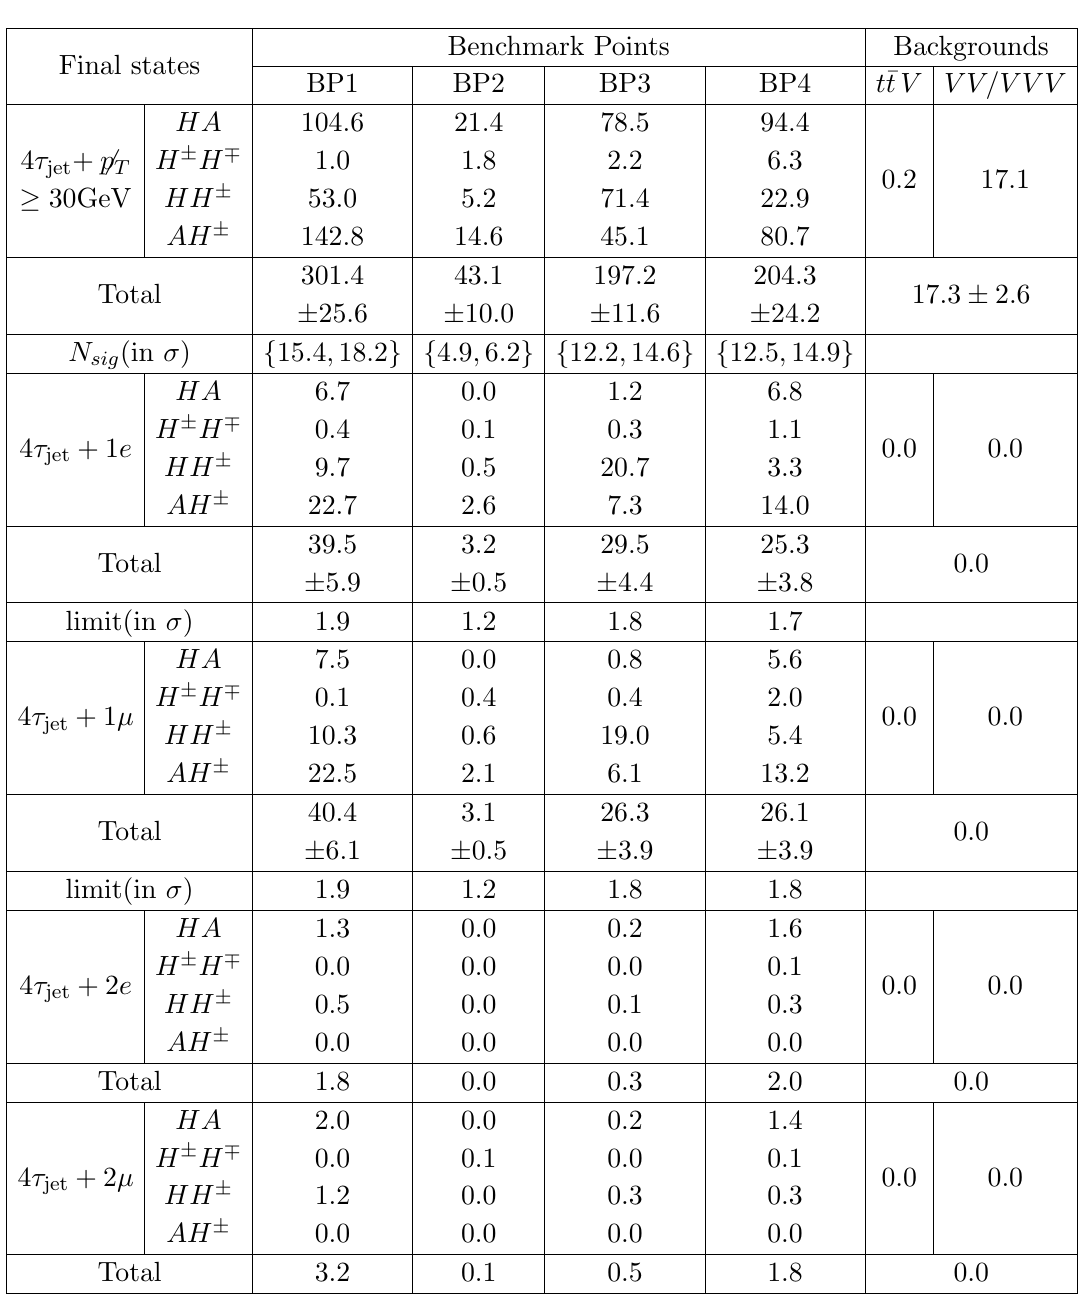
Table 9 . The number of events for 4 (cid:28) jet + 6 p T (cid:21) 30GeV, 4 (cid:28) jet + 1 ‘ and 4 (cid:28) jet + 2 ‘ (cid:12)nal states at 100 fb (cid:0) 1 of integrated luminosity at the LHC with 14 TeV center of mass energy. The range for N sig is calculated incorporating the systematic uncertainties in signal and background events as well. The (cid:13)avour tagging ( e; (cid:22) ) has been implemented.